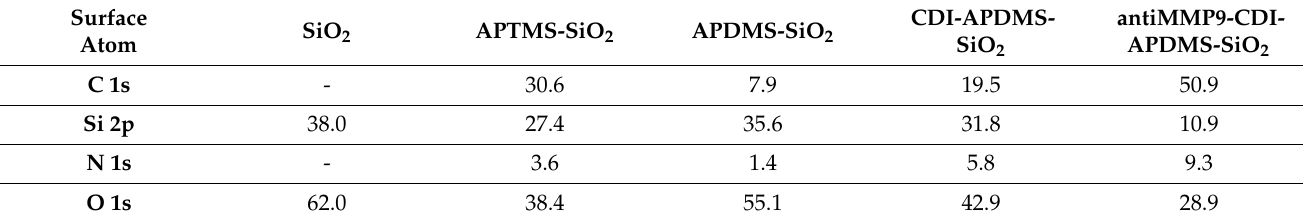
Table 3. XPS data of SiO 2 and thereafter modification with different functional groups (numbers in %). Surface